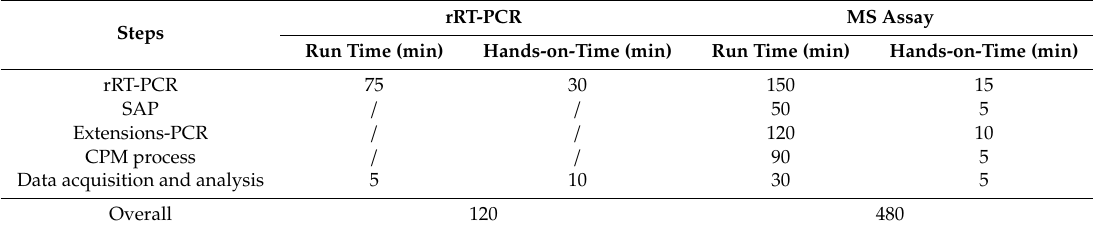
Table 2. Time-to-results and hands-on-time of the rRT-PCR and the commercial MS assay. Steps